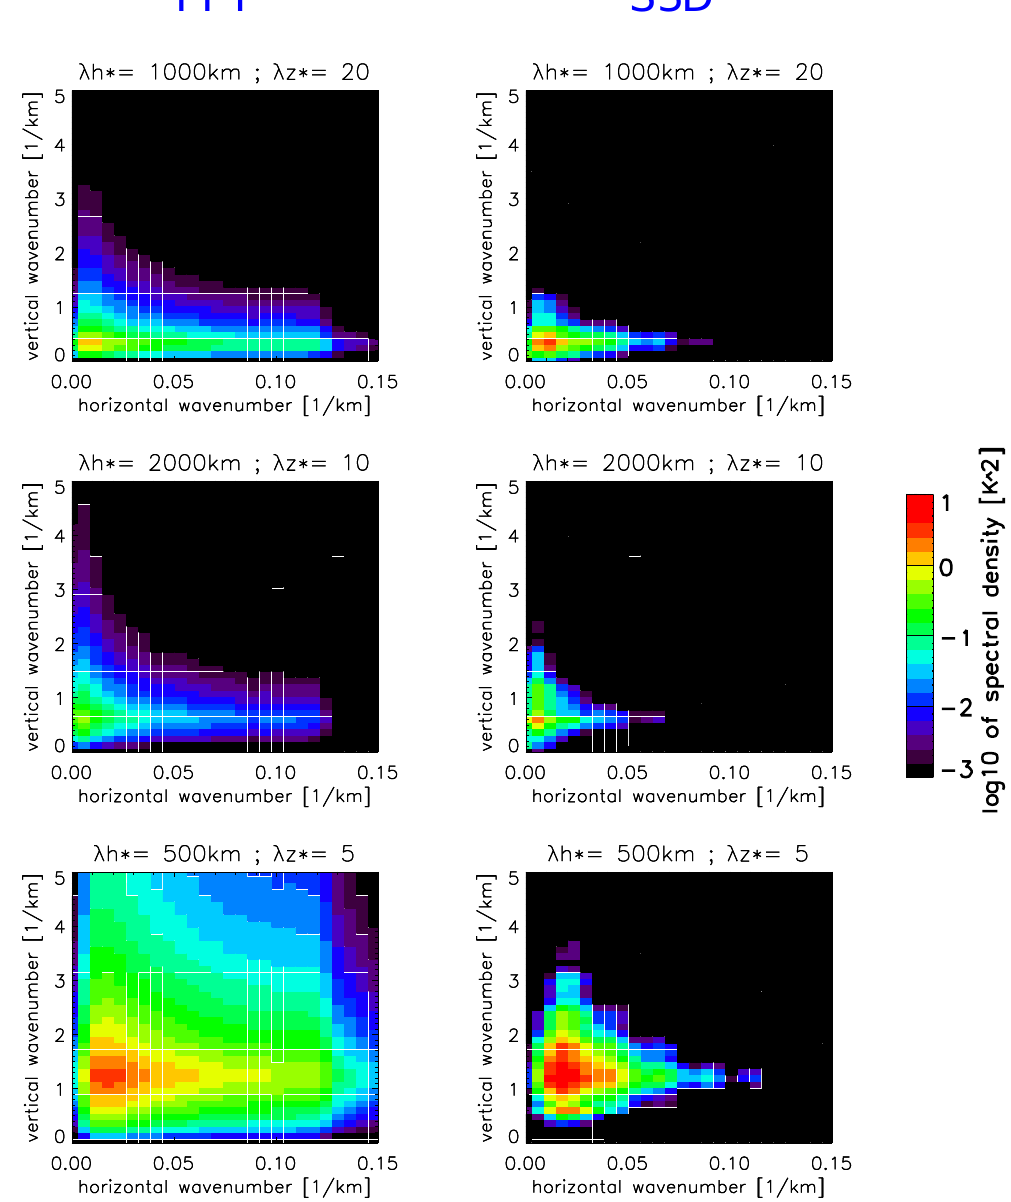
Fig. A2. Comparison of (left panels) Fourier transform and (right panels) S3D spectral intensity versus horizontal ( k 2 + l 2 ) and vertical